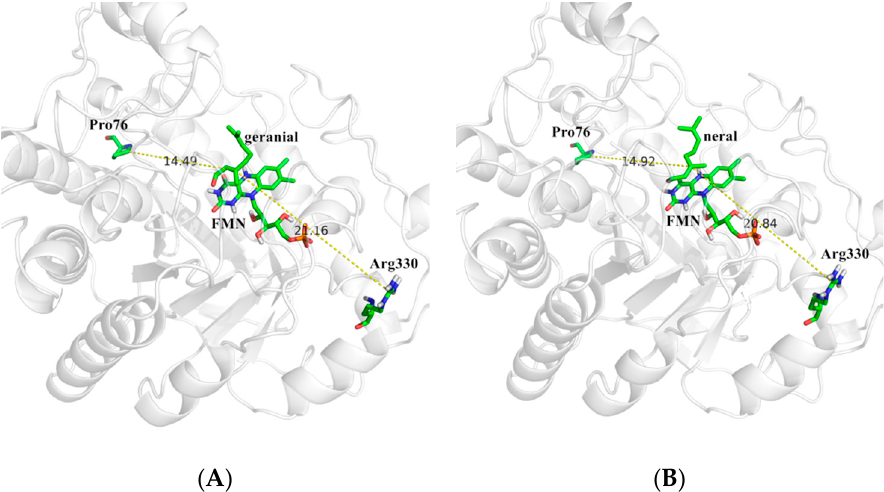
Figure 3. The residues targeted for site-saturation mutagenesis in the homology model of OYE2y. The model structure of OYE2y was constructed with the crystal structure of OYE1 (PDB code: 1OYB) as template. Distances between the C β atom of geranial ( A ) and neral ( B ) and side chains of P76 and R330 were determined. Green, carbon atom; blue, nitrogen atom; tangerine, oxygen atom; white, hydrogen atom; orange, phosphorus atom.